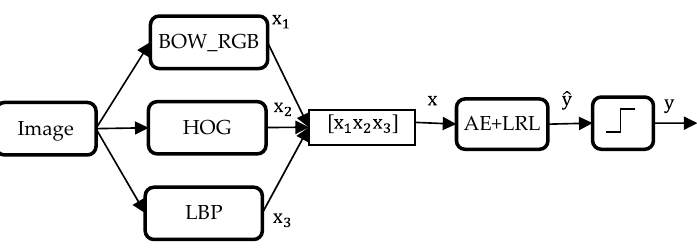
Figure 4. Diagram of the first fusion strategy (Fusion 1) based on a low-level feature aggregation.